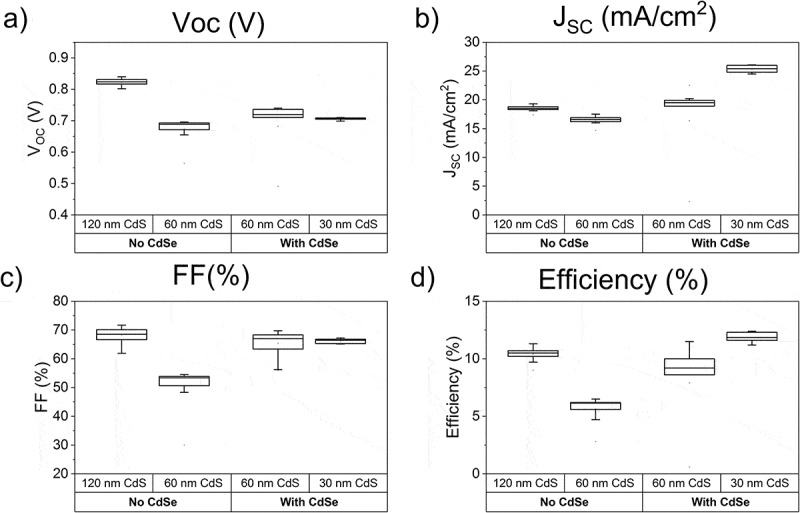
JV performance parameters of CdTe solar cells with and without CdTe1-xSex grading of the absorber towards the CdS window layer, and with varying CdS window layer thicknesses.